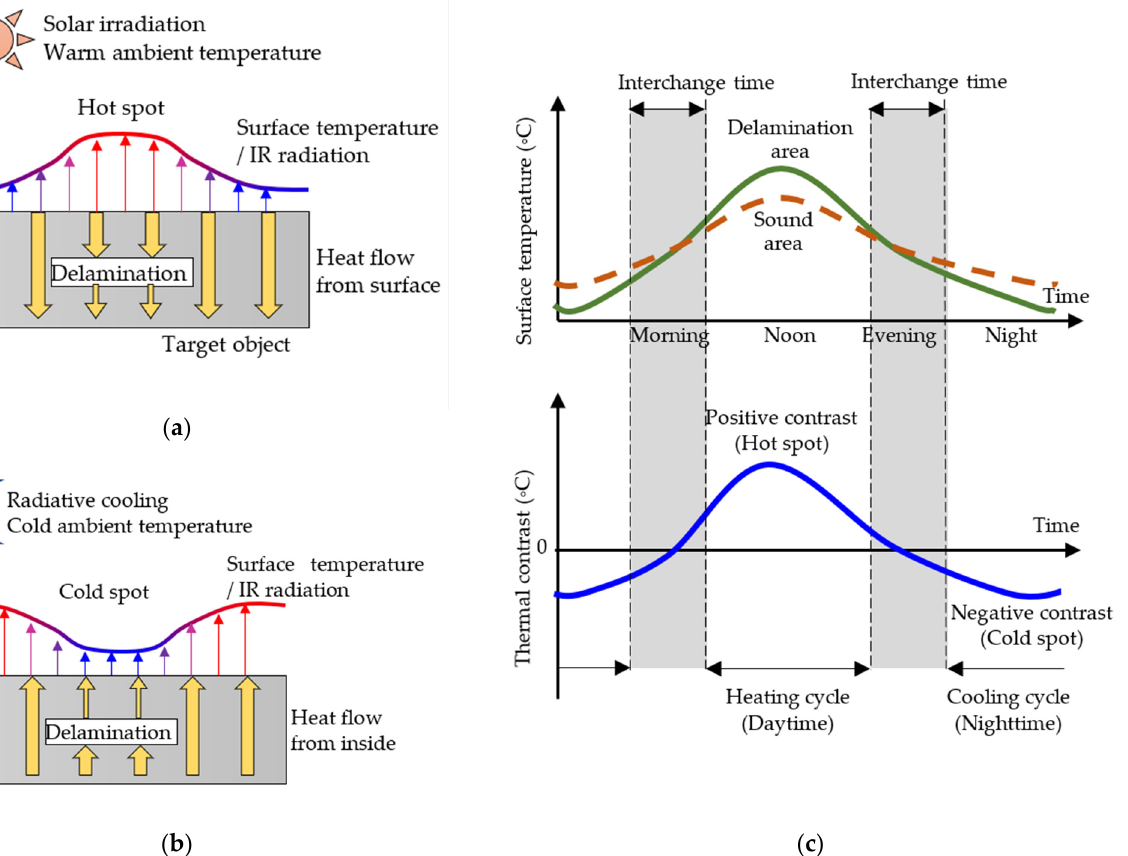
Figure 2. Principle of thermal contrast generation due to delamination: ( a ) diagram of heat flow during the heating cycle (daytime); ( b ) diagram of heat flow during the cooling cycle (nighttime); ( c ) daily changes of surface temperatures and thermal contrast.